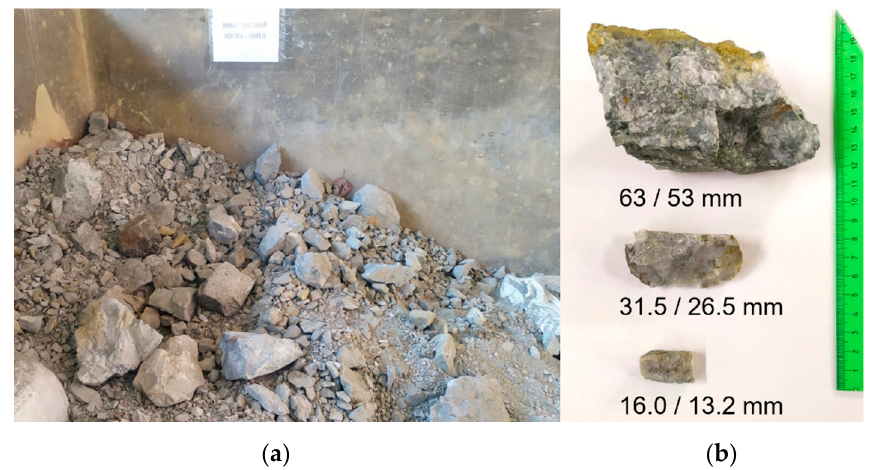
Figure 1. Run of Mine sample of the Íquira-Huila gold ore ( a ) and particles classified in narrow sizes ( b ).